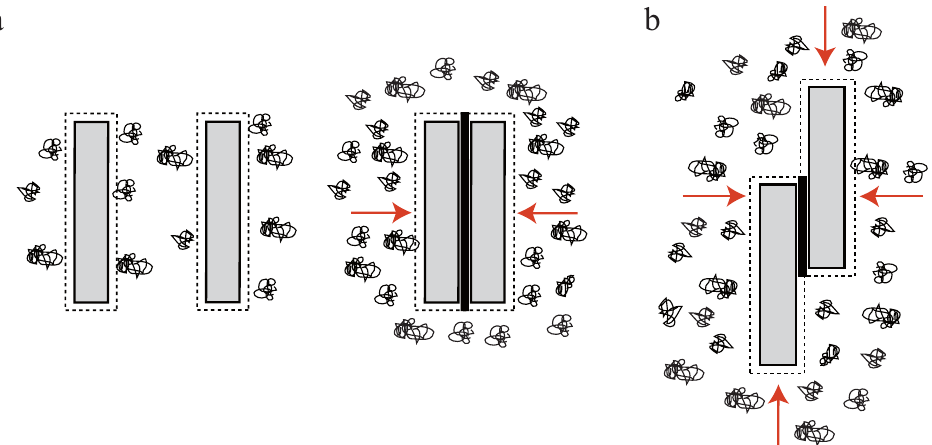
Figure 2. ( a ) High concentrations of non-interacting polymers—so-called crowding agents—in solution are causing attractive forces between colloidal, rod-like particles [35,36] when exceeding a threshold concentration C o . If excluded volumes of these suspended particles overlap, the total volume available for the non-interacting polymers increases. The newly available volume for polymers in solutions leads to an increase in entropy for the whole system; and ( b ) depletion forces arrange these rods with vertical as well as horizontal components (as indicated by the red arrows). If the rods are deflected along their axes, a constant restoring force arises, driving the system back to the equilibrium state with a maximized overlap ( black ) of excluded volumes. This figure is inspired by S. Asakura and